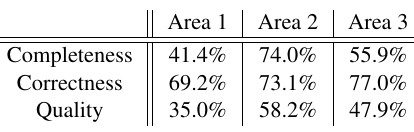
Table 4: Per-area accuracies of class trees